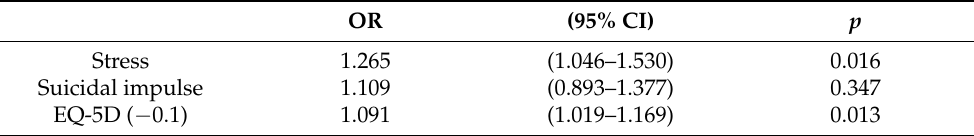
Table 3. Association between MAFLD and stress, mental health, and